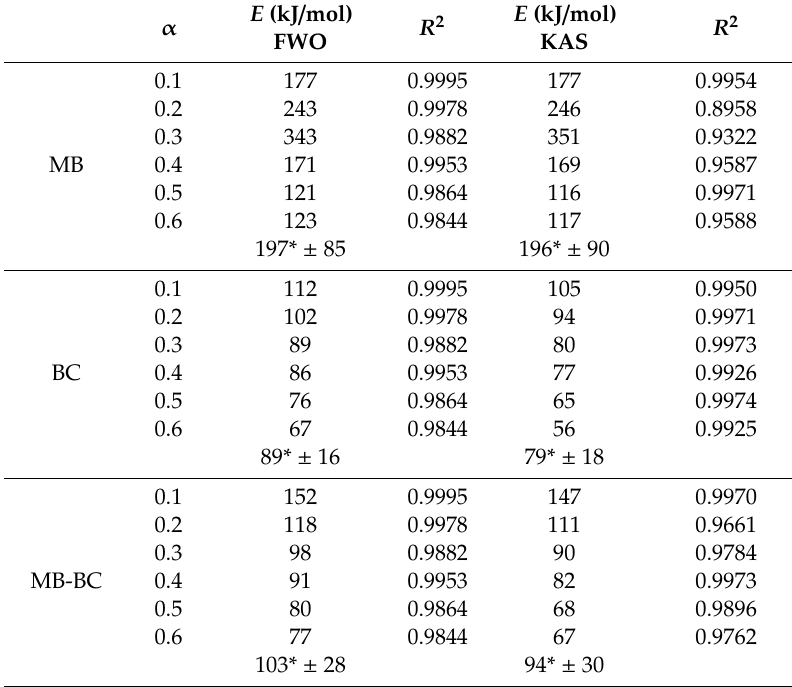
Table 7. Values of apparent activation energy ( E , kJ / mol) determined for the combustion of MB, BC and their blend (MB-BC) at the considered conversion degrees ( α ), together with R 2 corresponding to fittings in Figure 5. E (kJ / mol) α